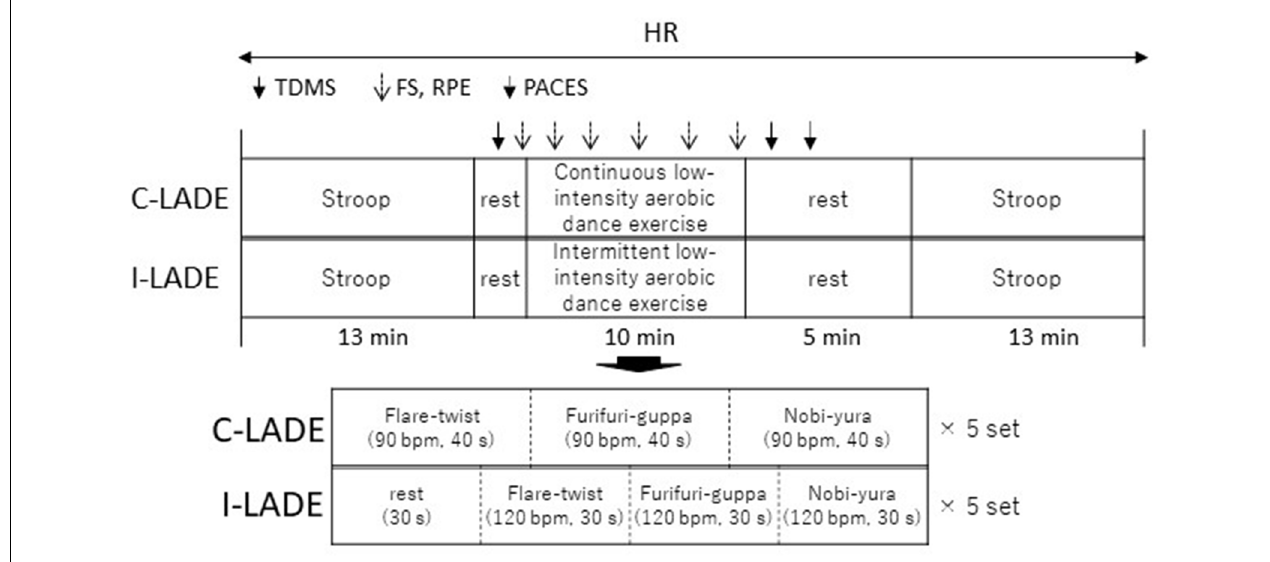
FIGURE 1 | Experimental procedure. HR, heart rate; TDMS, Two-Dimensional Mood Scale; FS, Feeling Scale; RPE, rating of perceived exertion; PACES, Physical Activity Enjoyment Scale.